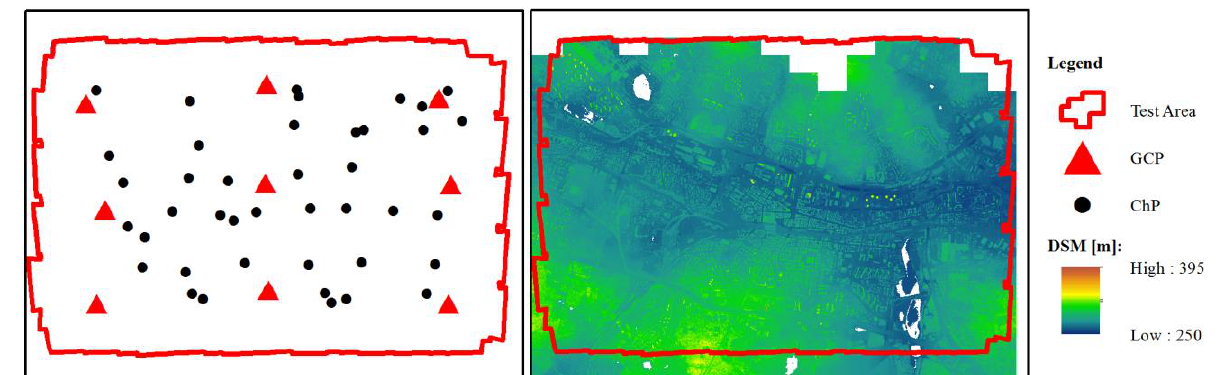
Figure 1. Left: Map of GCP distribution, markers: Red triangle – Ground Control Point, Black dot – Check Point. Right: Digital Surface Model of test area (marked with red